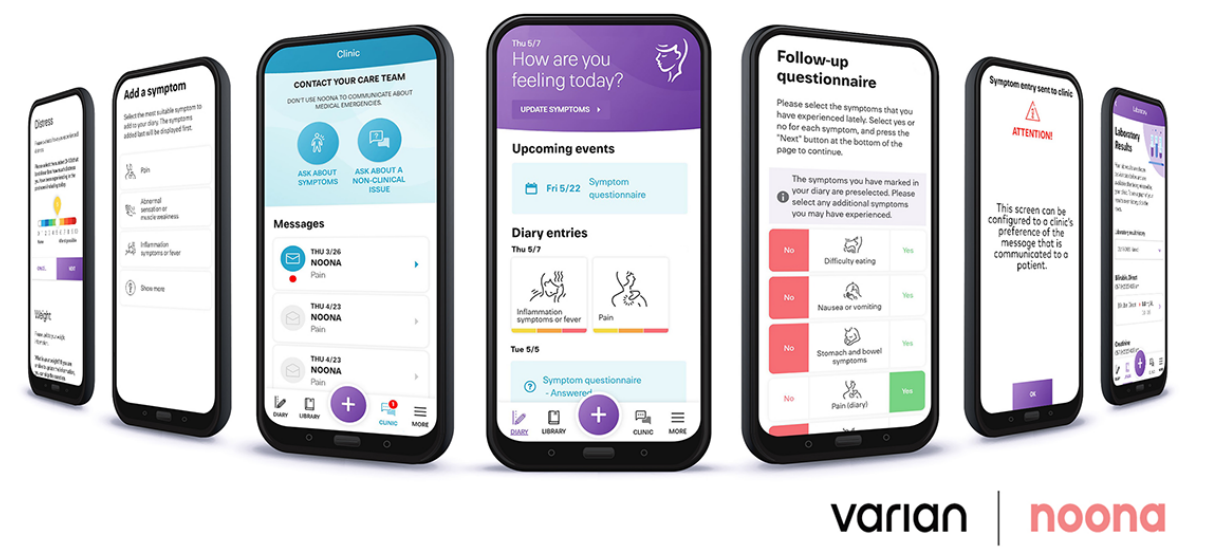
Figure 1. Noona interface for the